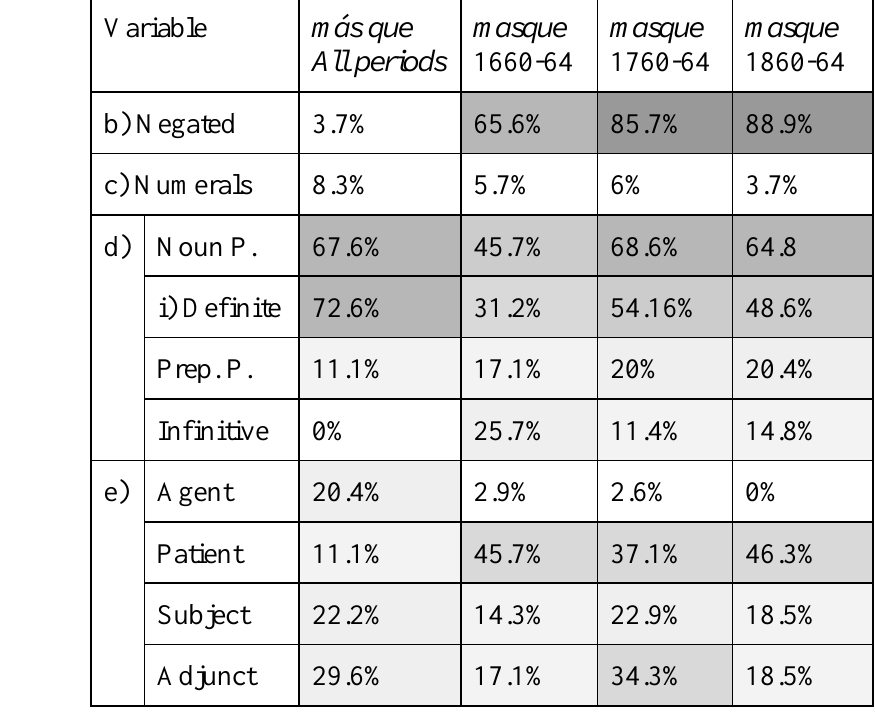
Table 4. Types of más que and associated properties in